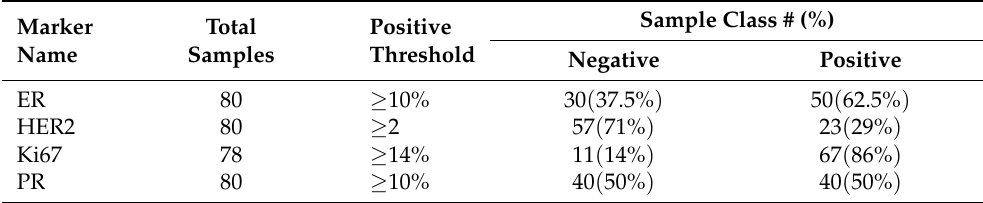
Table 3. Thresholds used to define the DS M positive/negative classes, and the derived distribution of the samples among